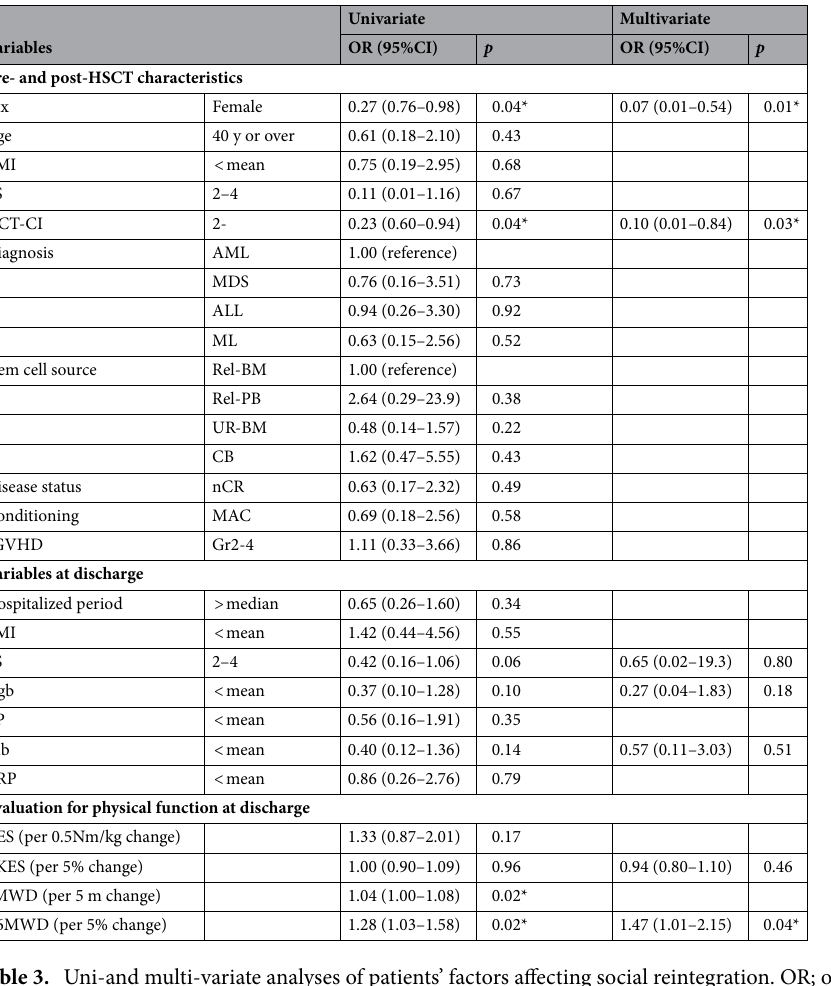
Table 3. Uni-and multi-variate analyses of patients’ factors affecting social reintegration. OR; odds ratio, CI; confidence interval, HSCT; hematopoietic stem cell transplantation, BMI; body mass index, PS; performance status, HCT-CI; hematopoietic cell transplantation comorbidity index, AML; acute myeloid leukemia, MDS; myelodysplastic syndrome, ALL; acute lymphoblastic leukemia, ML; malignant lymphoma, Rel; related, UR; unrelated, BM; bone marrow, PB; peripheral blood, CB; cord blood, nCR; non complete remission, MAC; myeloablative conditioning, aGVHD; acute graft-versus-host disease, BMI; body mass index, PS; performance status, Hgb; hemoglobin, TP; serum total protein, Alb; serum albumin, and CRP; C-reactive protein, KES; knee extensor strength, and 6MWD; 6-min walking distance. ∆ indicates difference between pre- and post-HSCT. * indicates statistically